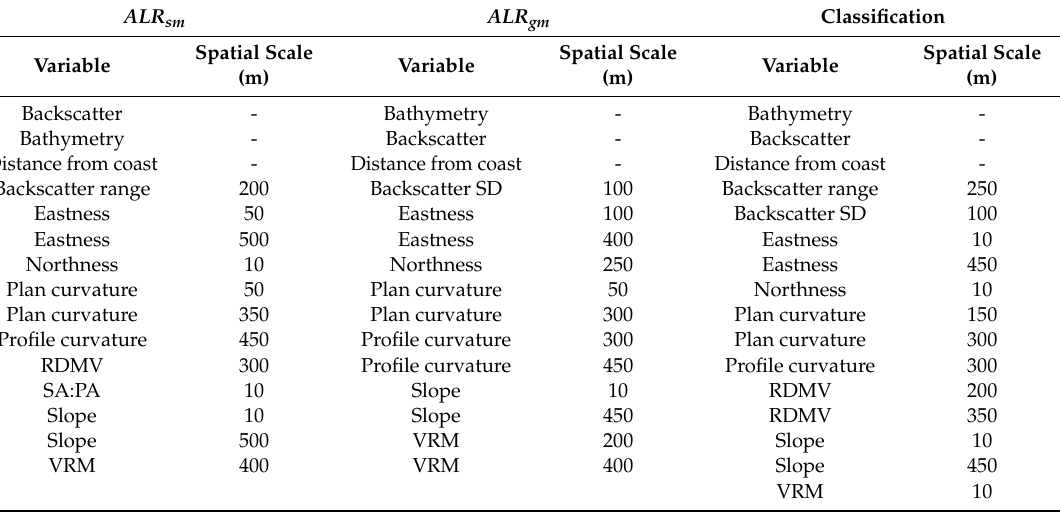
Table 2. Scale-specific variables selected for sediment grain size models.